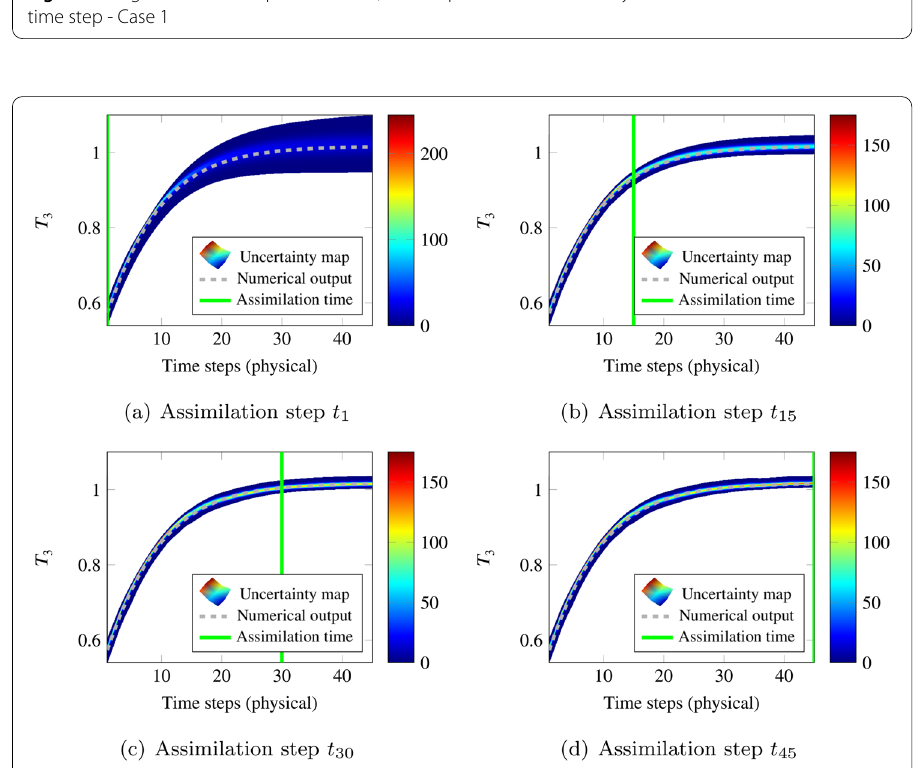
Fig. 13 Prediction of the output T 3 for all time steps after the considered assimilation step - Case 1